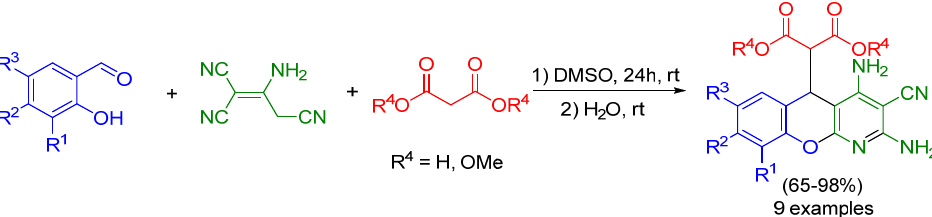
Figure 1. Some biologically active chromeno[2,3- b ]pyridines.